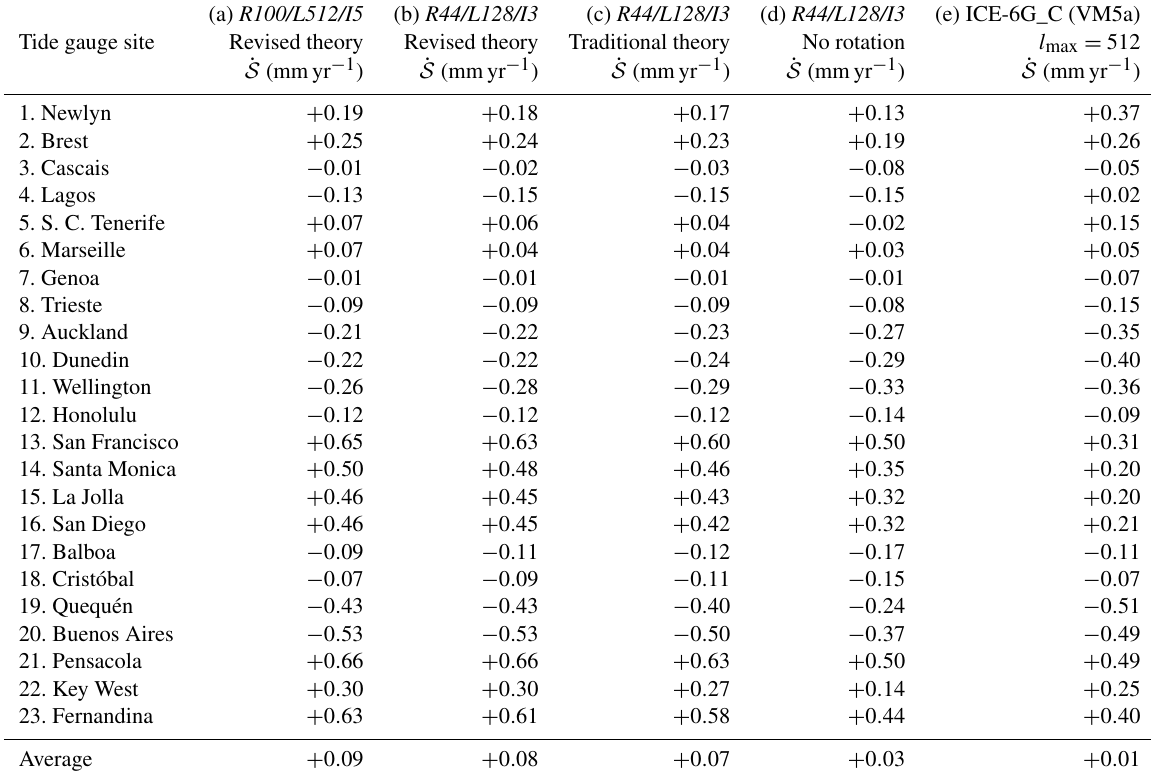
Table 5. Present-day rates of sea-level change at the 23 Douglas (1997) tide gauges for the test run of SELEN 4 (column b) and for other configurations. Results based upon the original implementation of model ICE-6G_C (VM5a) are reproduced in column (e). The average rate is also shown in the bottom line. The SELEN 4 outputs have been rounded to two significant